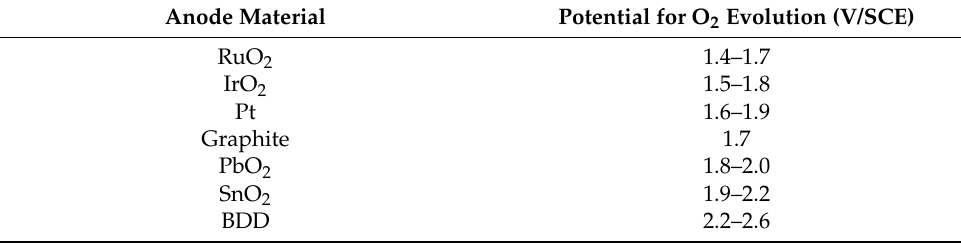
Table 4. O 2 evolution potential of various anode materials